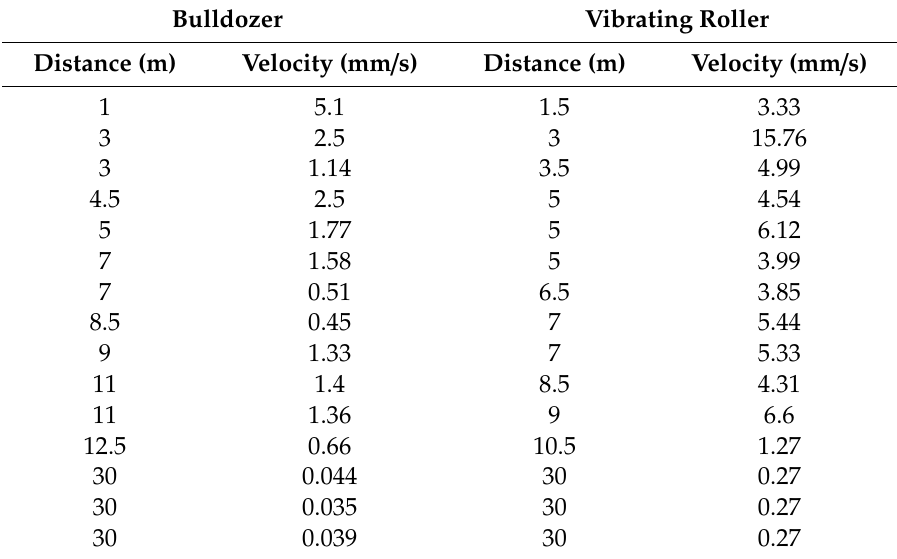
Table 4. Backfill operations with di ff erent